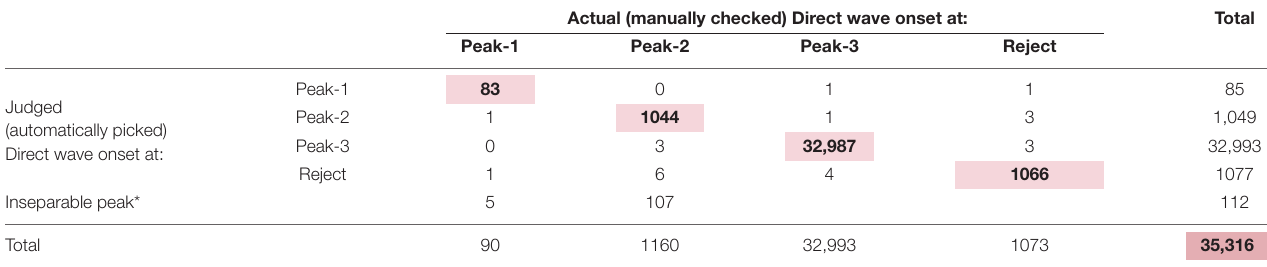
*The CCF peaks overlapped due to extremely short path difference between the direct and the reflected waves. The colored values indicate the number of data.